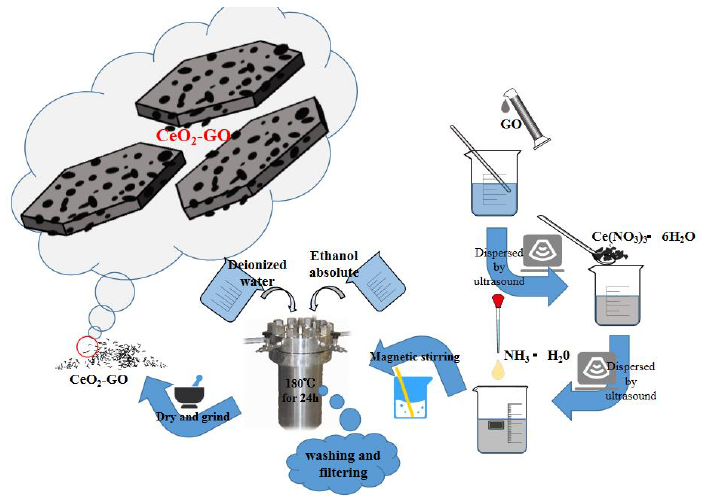
Figure 1. A schematic of synthesized process of cerium oxide-graphene oxide (CeO 2 -GO) nano- composites.